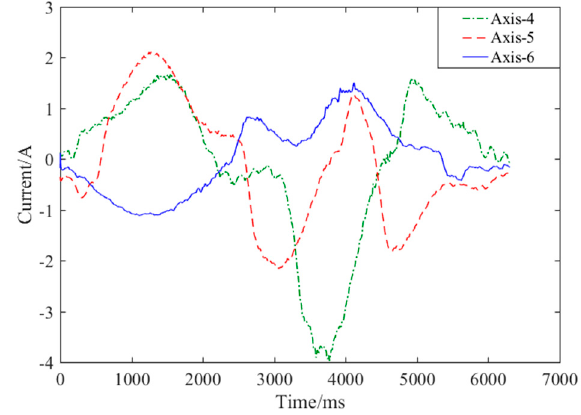
Figure 11. Actual motor current of axis 4, 5 and 6.